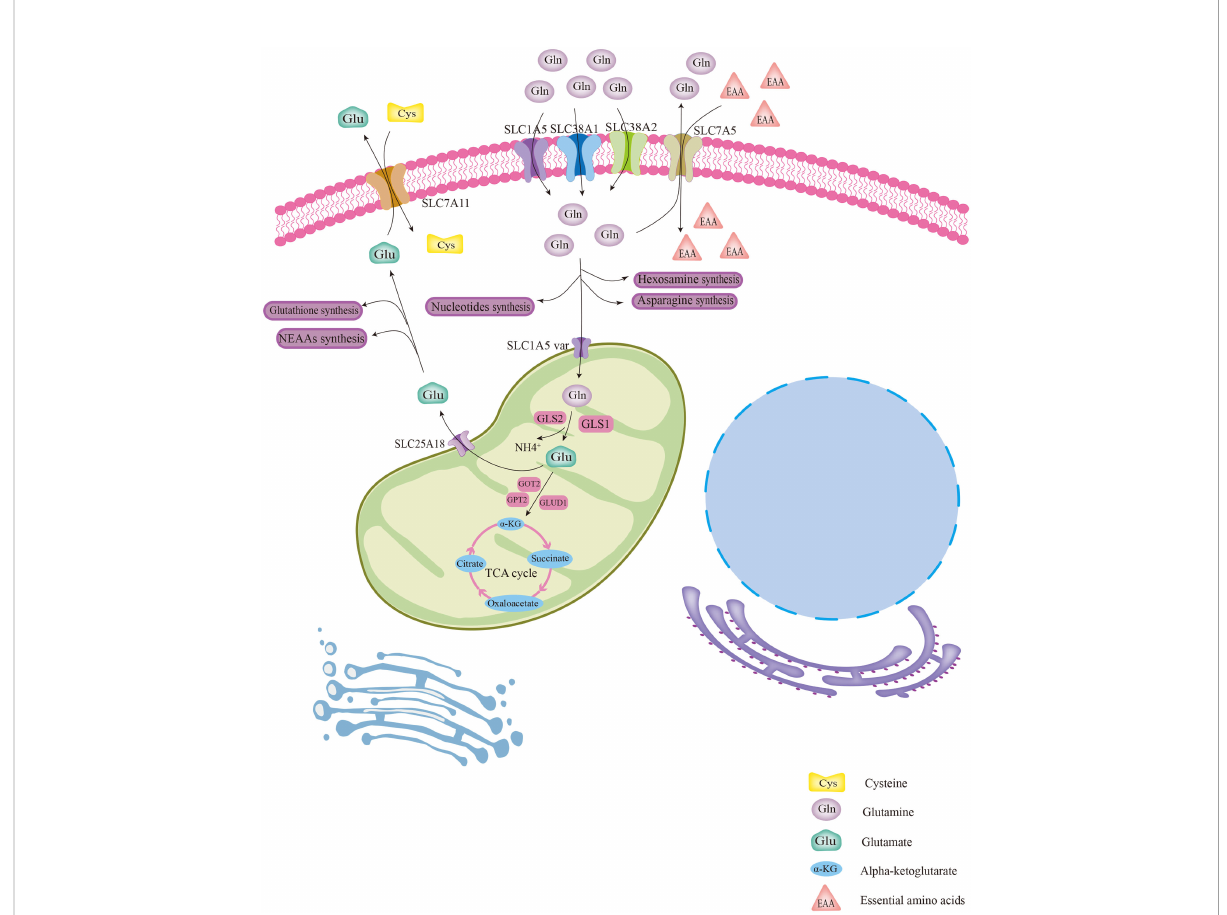
FIGURE 1 The biological process of glutamine metabolism in cells. Glutamine enters the cytoplasm with the help of several membrane transport proteins and is used for the synthesis of other biomolecules, such as hexosamine, nucleotides, and asparagine. Part of intracellular glutamine (Gln) is transported into the mitochondrial matrix via the SLC1A5 variant and subsequently converted to glutamate (Glu) with the help of GLS. Then, by catalysis of GLUD1 or several aminotransferases, Glu was converted to a -KG, which is involved in the TCA cycle. Glu was also transported out of mitochondria for the synthesis of glutathione and NEAAs via the transporter protein SLC25A18. The cytoplasmic Gln and Glu can be exchanged with extracellular EAAs and cystine, respectively, via transporter